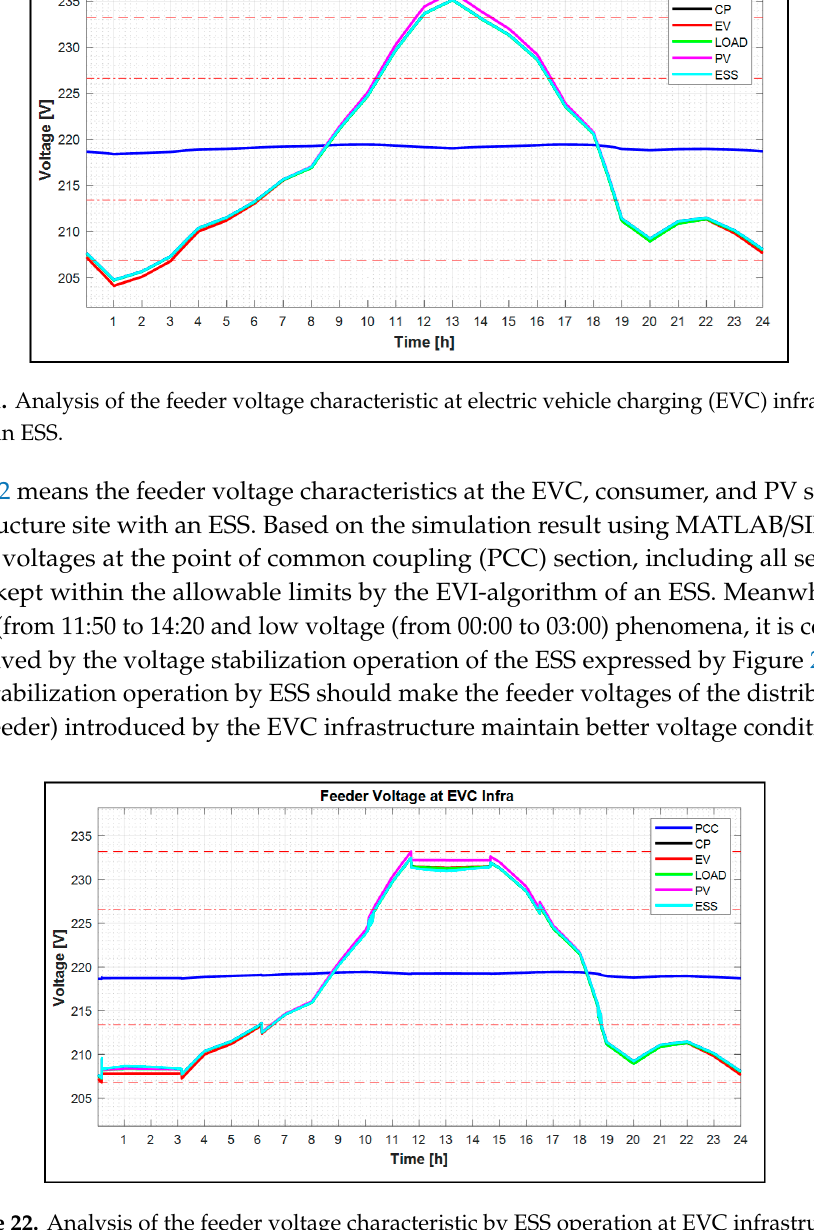
Figure 22. Analysis of the feeder voltage characteristic by ESS operation at EVC infrastructure.